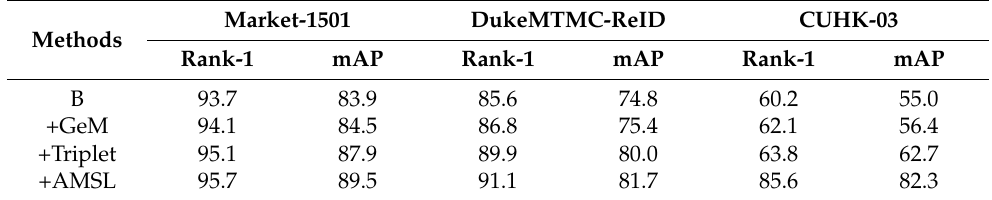
Table 7. Ablation experiments of AML